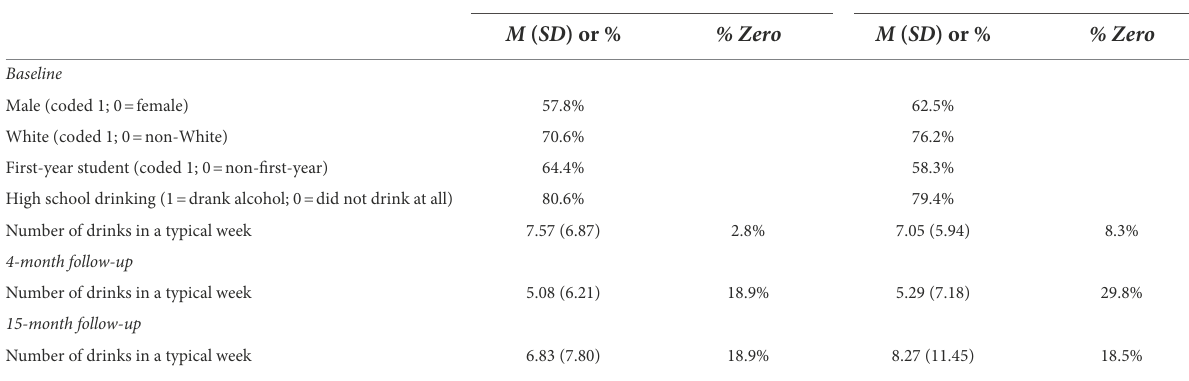
TABLE 1 Descriptive statistics of the study